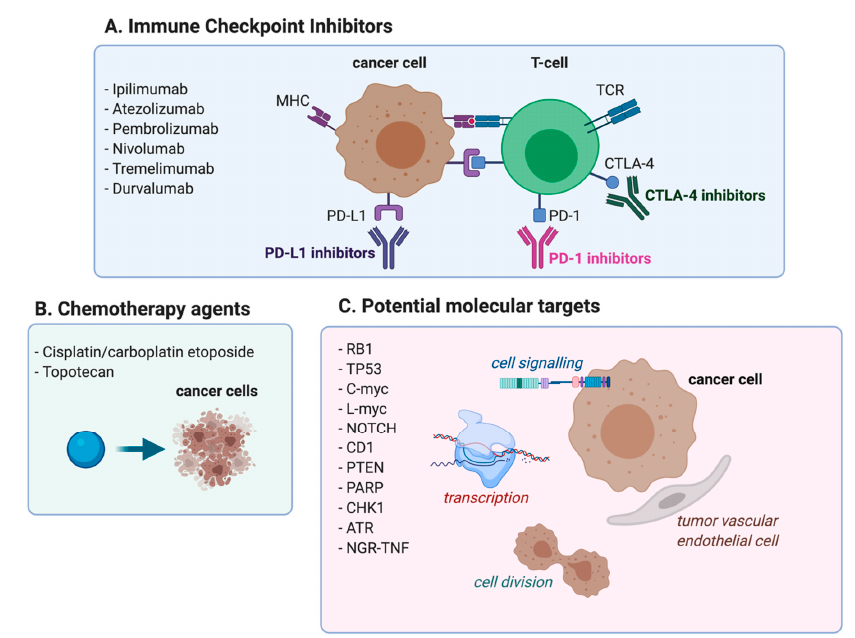
Figure 1. ( A ) Immunotherapy treatment strategies currently approved or tested in patients with ED-SCLC. ( B ) Approved chemotherapy treatments for patients with ED-SCLC. ( C ) Potentially targetable and identified molecular pathways in ED-SCLC.